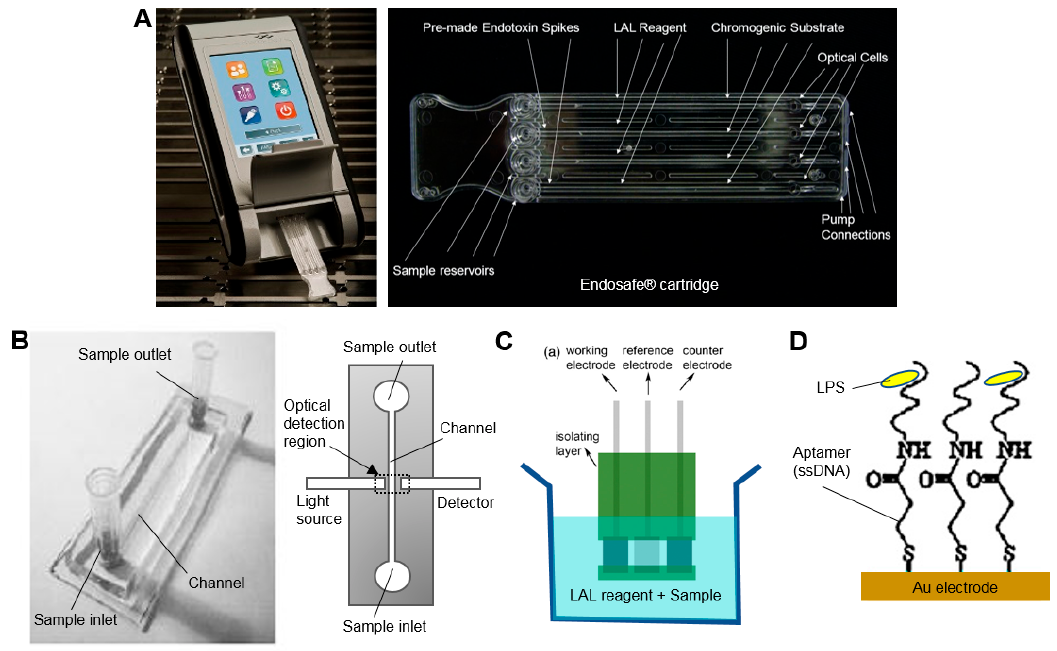
Figure 4. Examples of microfluidic devices for bacterial endotoxin test. ( A ) Commercial LAL assay system (Endosafe ® , Charles River Laboratories, Inc.) comprising a portable, hand-held spectrometer ( left ) and ~25 mm × 75 mm disposable microfluidic cartridge ( right ). Adapted from [56]. ( B ) Photograph of microfluidic LAL test chip ( left ) and block diagram illustrating detection method ( right ). Sample mixed with chromogenic substrate is loaded into the microchannel and optical detection is performed in the middle of channel. Photograph adapted with permission from [57] Copyright © 2004 Springer. ( C ) Screen-printed electrodes for electrical-impedance monitoring of standard gel clot LAL assay. Adapted with permission from [58] Copyright © 2013 Elsevier. ( D ) Biosensor comprising a gold electrode functionalized with endotoxin-specific aptamer. Binding of endotoxin is detected via impedance spectroscopy. Adapted with permission from [60] Copyright © 2012 Elsevier.